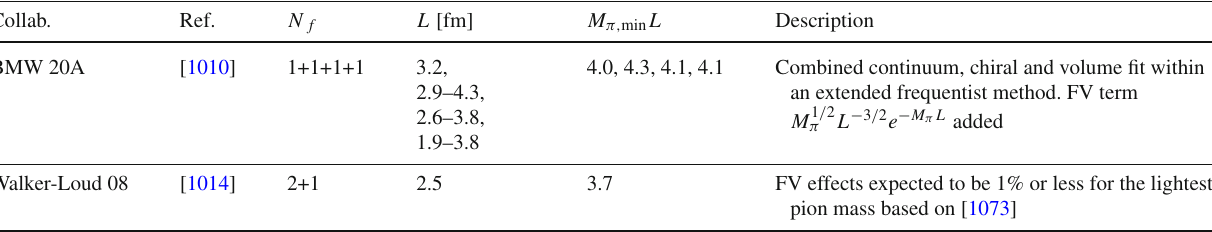
Table 196 Finite-volume effects in determinations of σ π N and σ s from the Feynman–Hellmann method Collab.